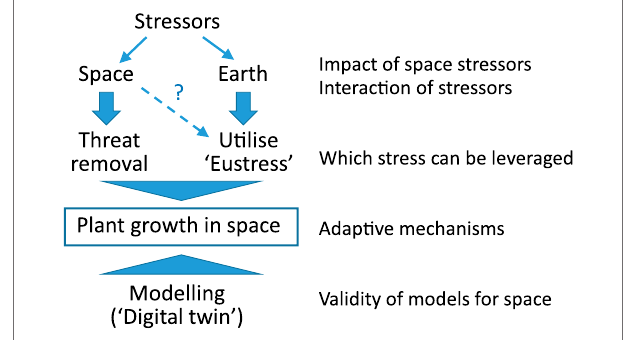
FIGURE3| Stressandeustressforplantgrowthinspace,andtheroleof modelling to make forecasts